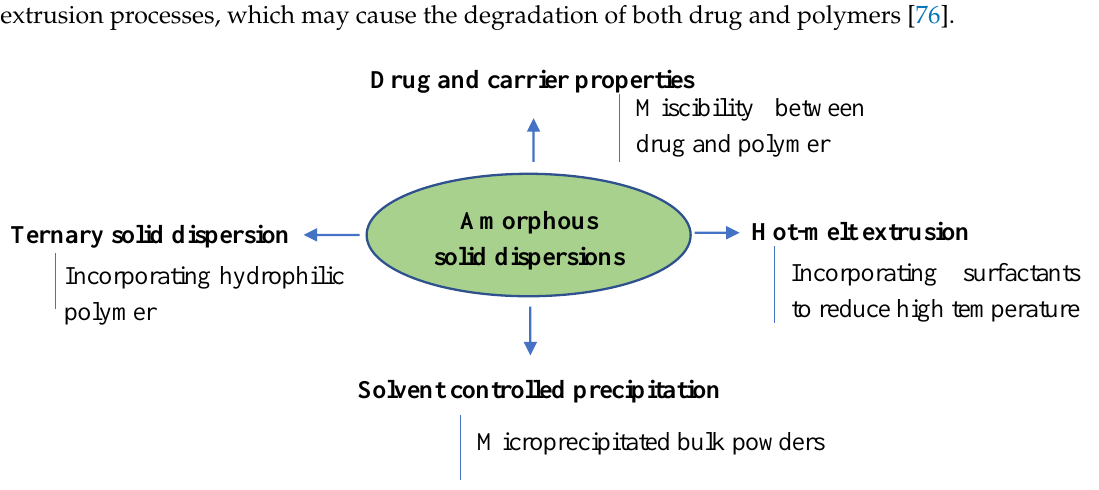
Figure 3. Illustration of factors from enteric coating polymers affecting amorphous SDs.